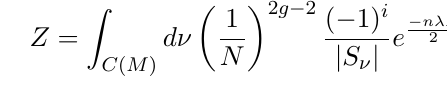
Figure 4 . A 3-sheeted covering map of the torus T 2 with two interaction branch points q covering map (cid:23) is de(cid:12)ned here by vertical projection. A counterclockwise loop encircling the target space branch point q 1 lifts to a permutation p 1 : 1 shows an initial closed string breaking into two and then joining back together